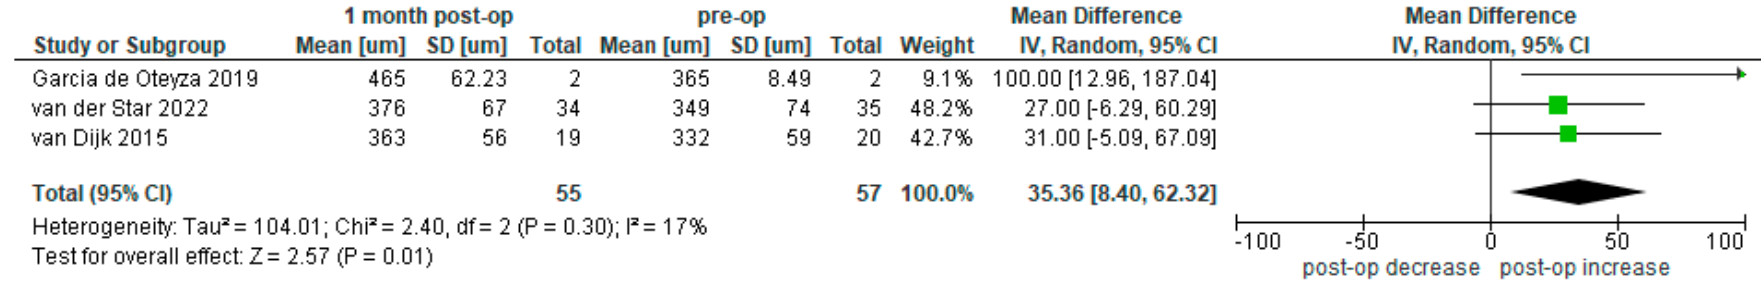
Figure A2. Di ff erence in best contact lens-corrected visual acuity across 1 study [43].